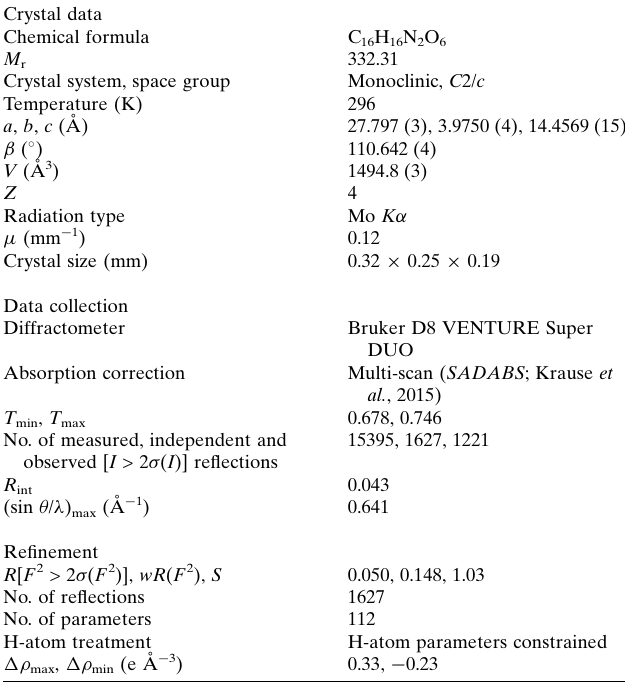
Table 2 Experimental details. Crystal data Chemical formula